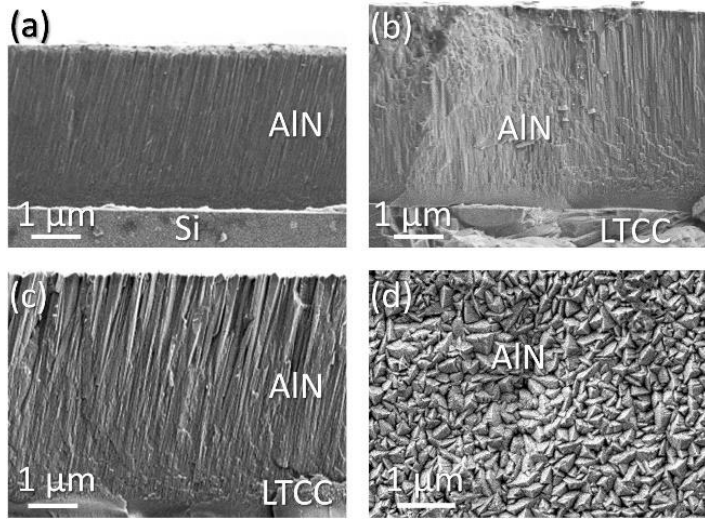
Figure 5. SEM micrographs, samples sputtered with N 2 /Ar ratio of 5%: ( a ) #2 on silicon; ( b ) #2 on ceramic; ( c ) #7 on ceramic; ( d ) #7 top view on AlN (substrate ceramic).